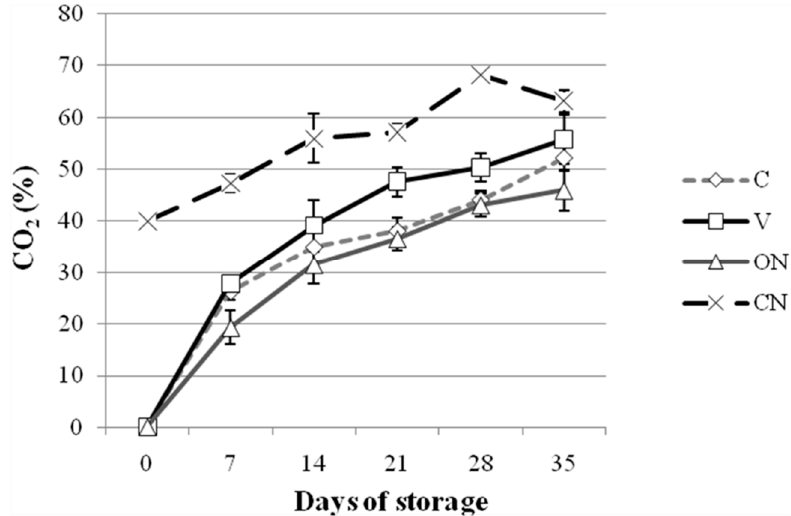
Figure 1. Evolution of the CO 2 composition of Tuber melanosporum in four different MAP: modified atmosphere packaging. C: air atmosphere; CN: mix of 40% CO 2 / 60% N 2 ; ON: mix of 1% O 2 / 99% N 2 ; V: hypobaric packaging at 30 kPa. Bars indicate the standard deviation.